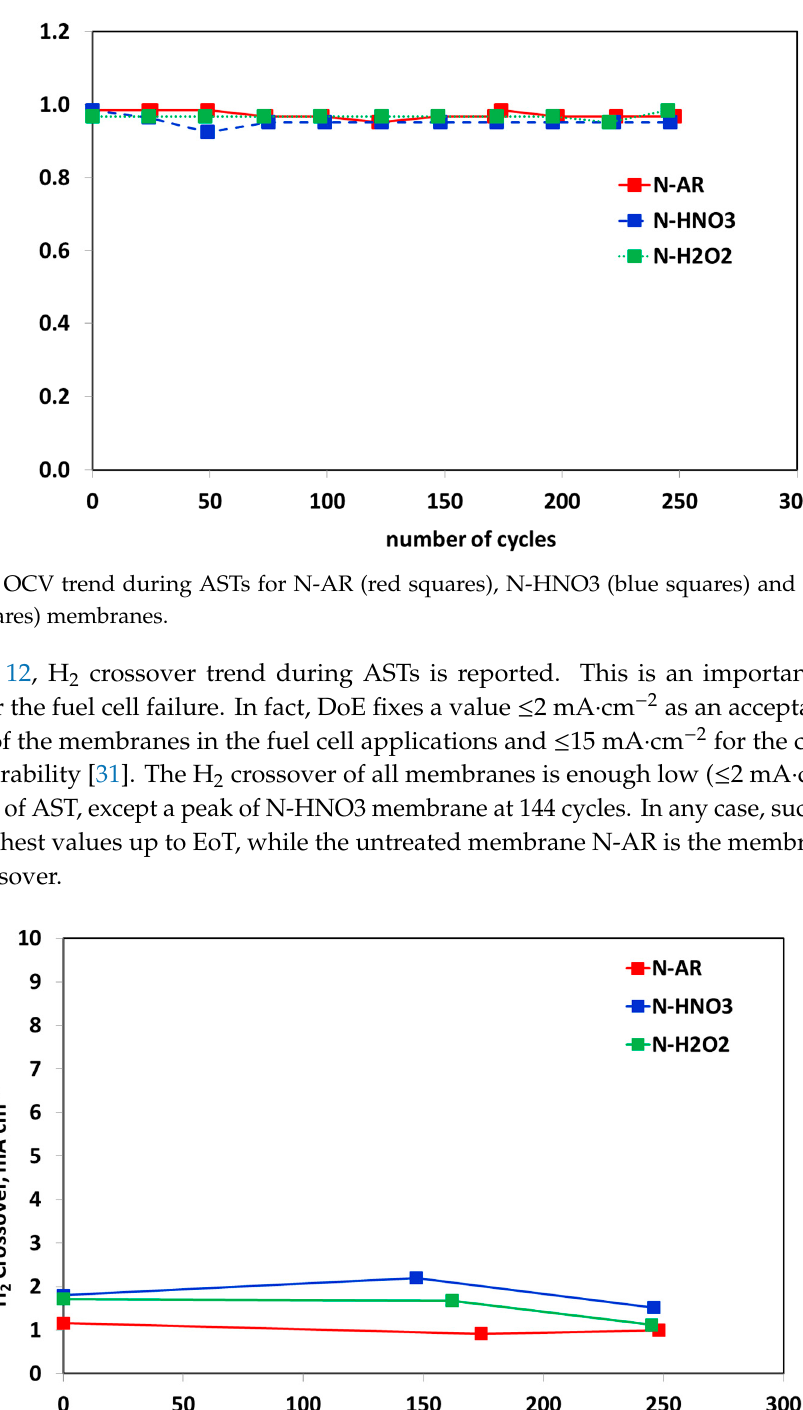
Figure 10. Trend of Rs measured from EIS as a function of time for N-AR (red squares), N-HNO3 (blue squares) and N-H2O2 (green squares) membranes.